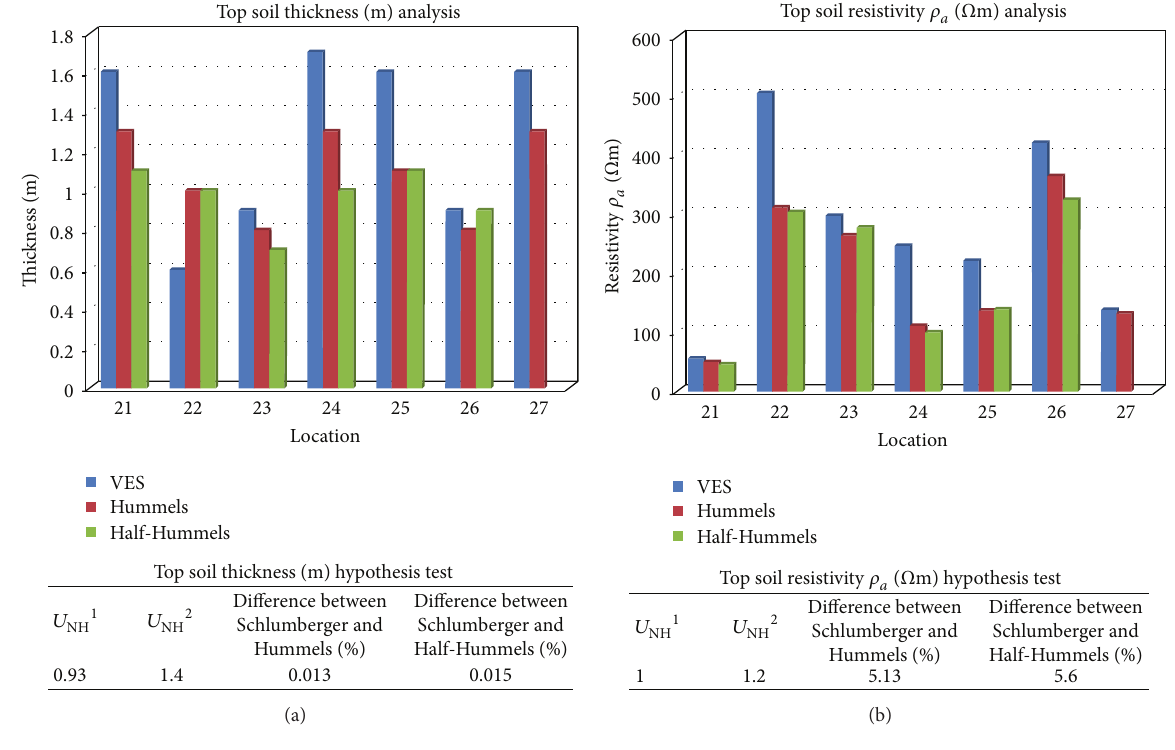
Figure 18: Bar chart and statistical test of hypothesis table for the different array methods comparing (a) topsoil thickness and (b) topsoil resistivity, for stations on augen gneiss.